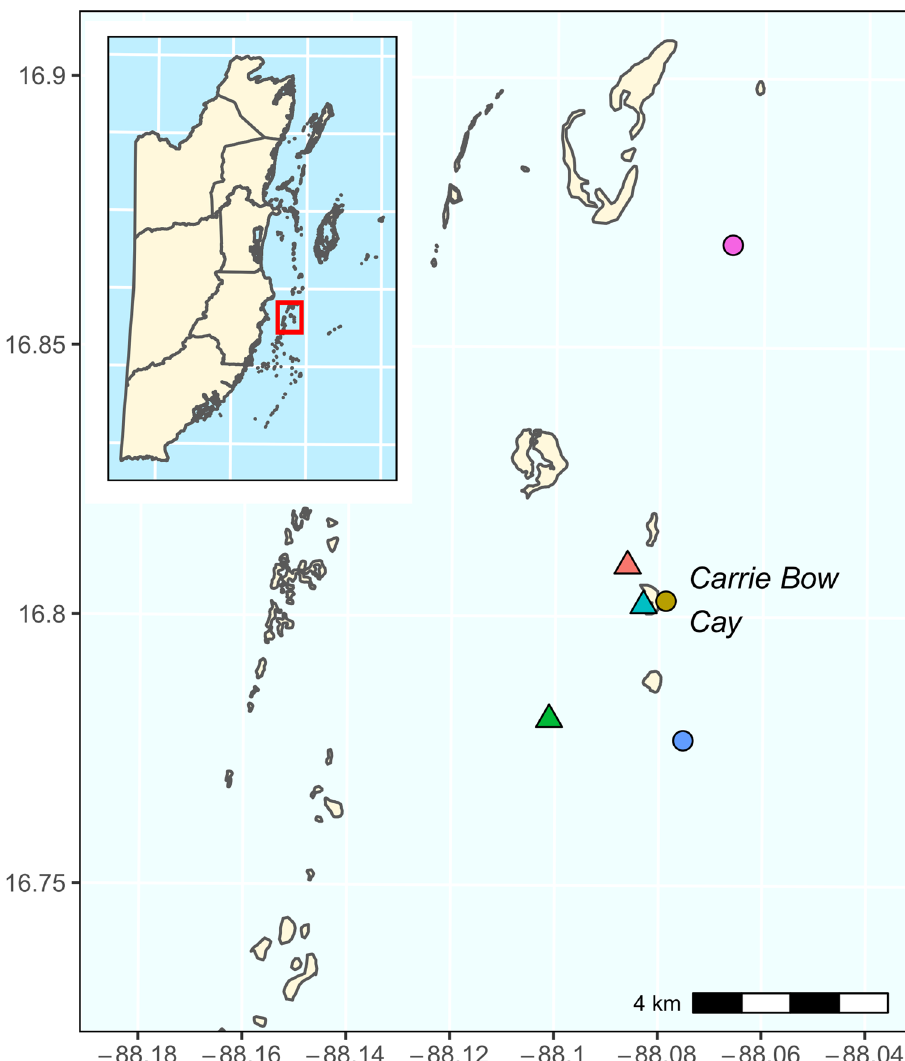
and symbols correspond to reef sites/types in the legend of Fig. 3. To generate the map, we used the sp 24 and sf 25 packages in R version 4.0.5 26